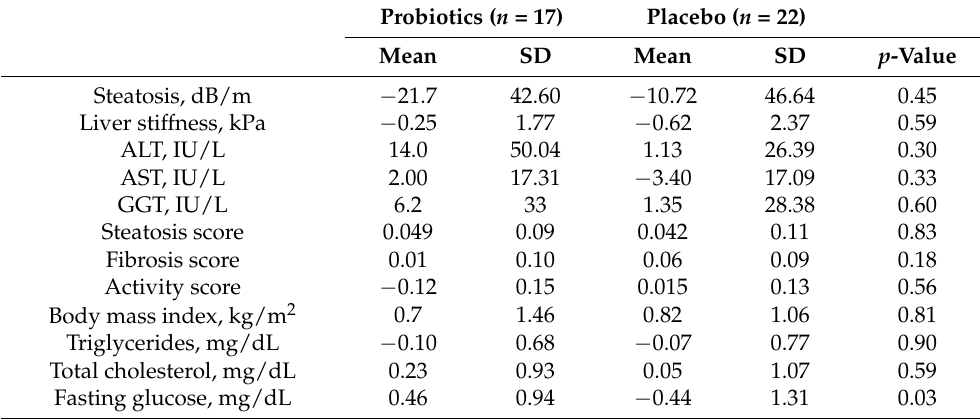
Table 4. Mean changes in the study parameters between the groups from baseline to the end of the